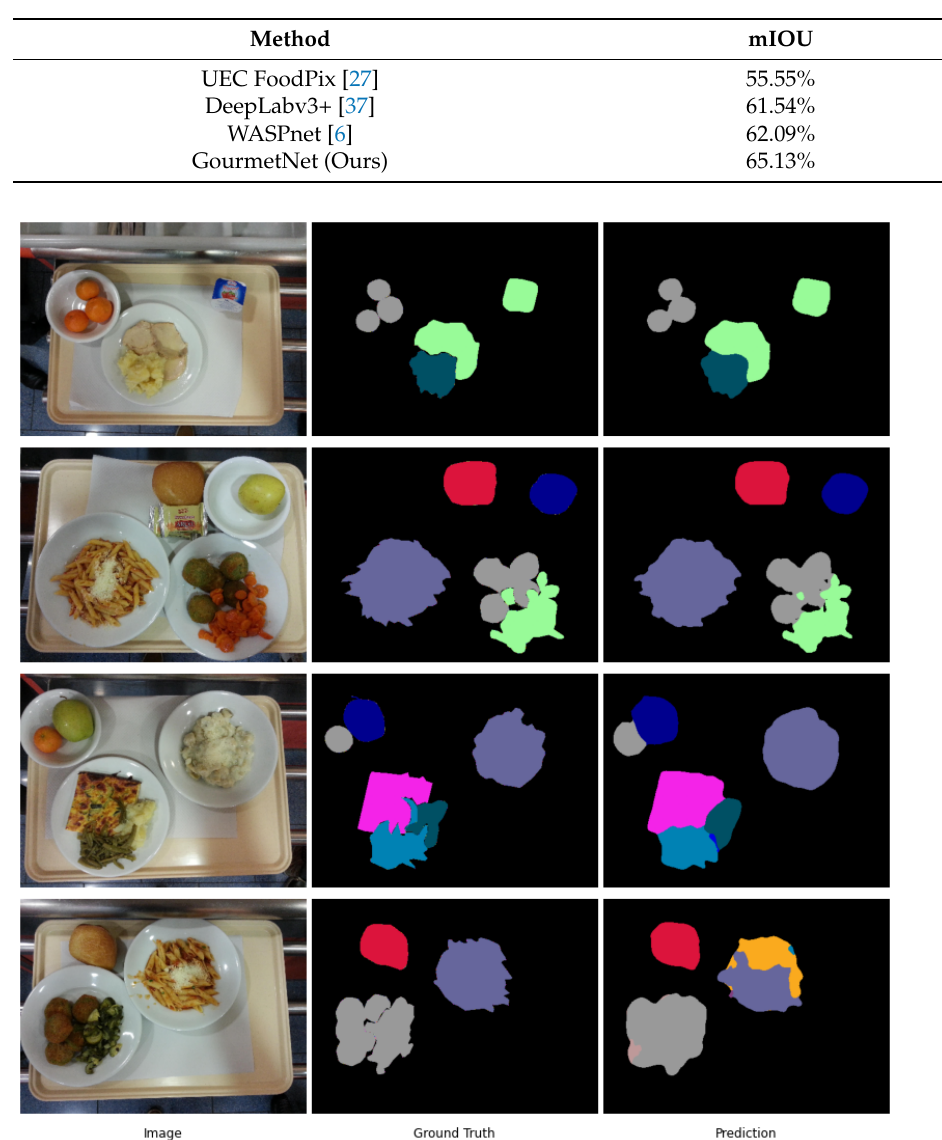
Figure 6. Segmentation examples using GourmetNet for the UNIMIB2016